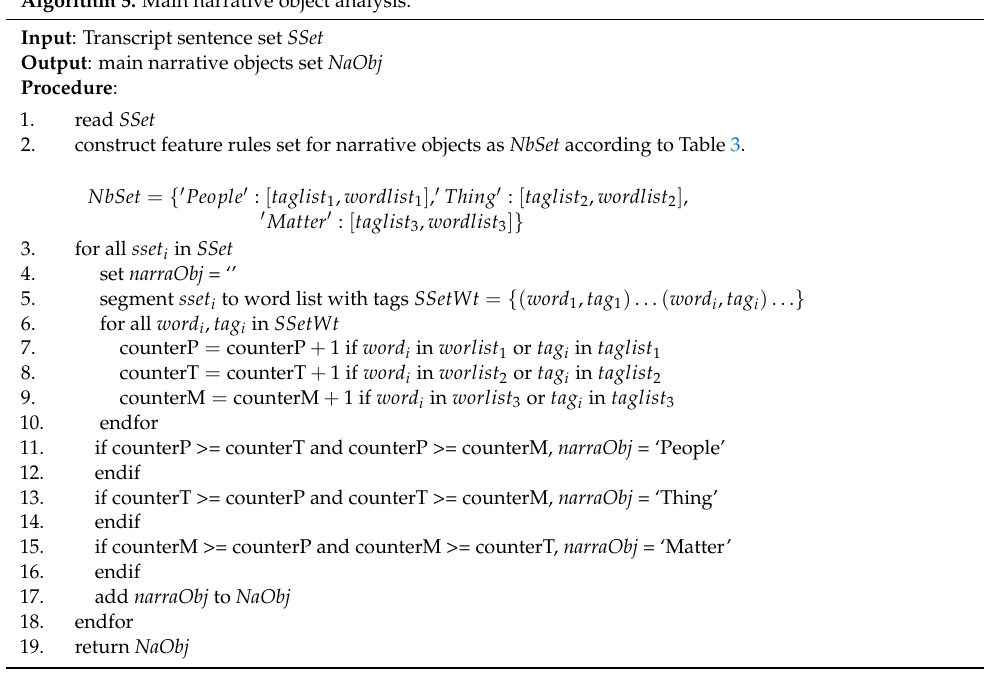
Algorithm 5. Main narrative object analysis.